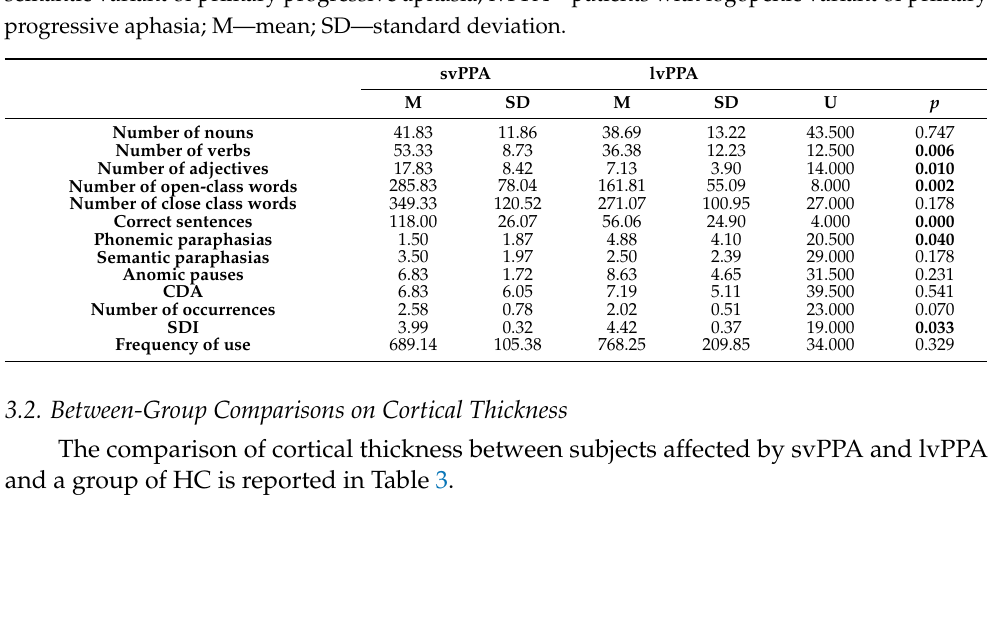
Table 2. Means and standard deviations (SD) of linguistic features derived for both clinical